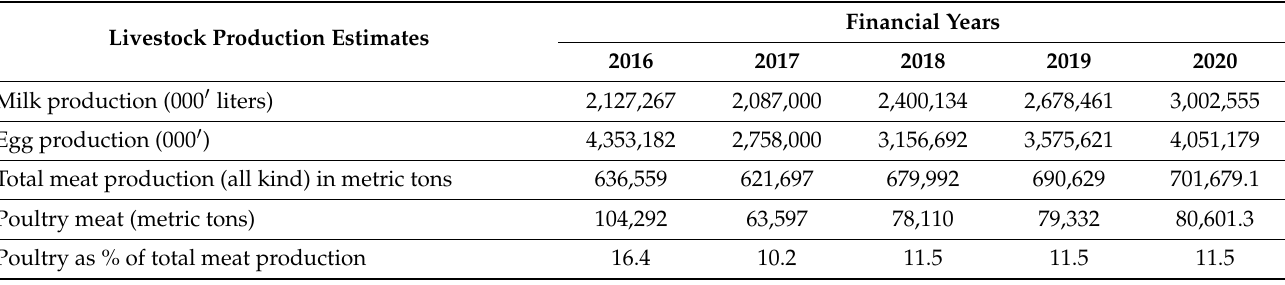
Table 3. Five years national livestock population and production trend in Tanzania from 2015 to 2020. Livestock Production